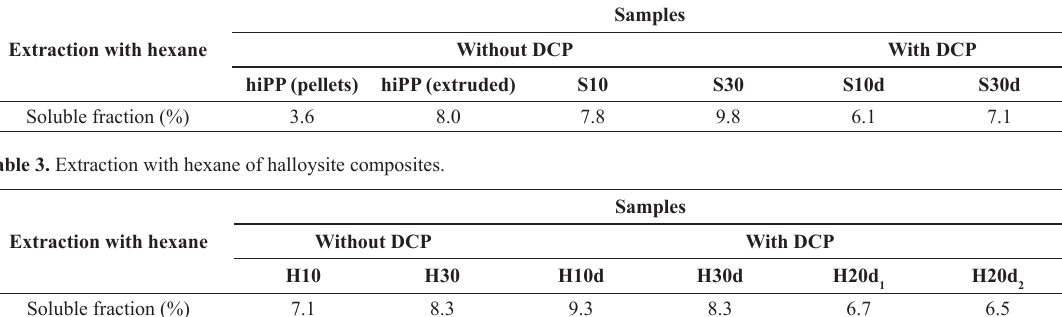
Extraction with hexane